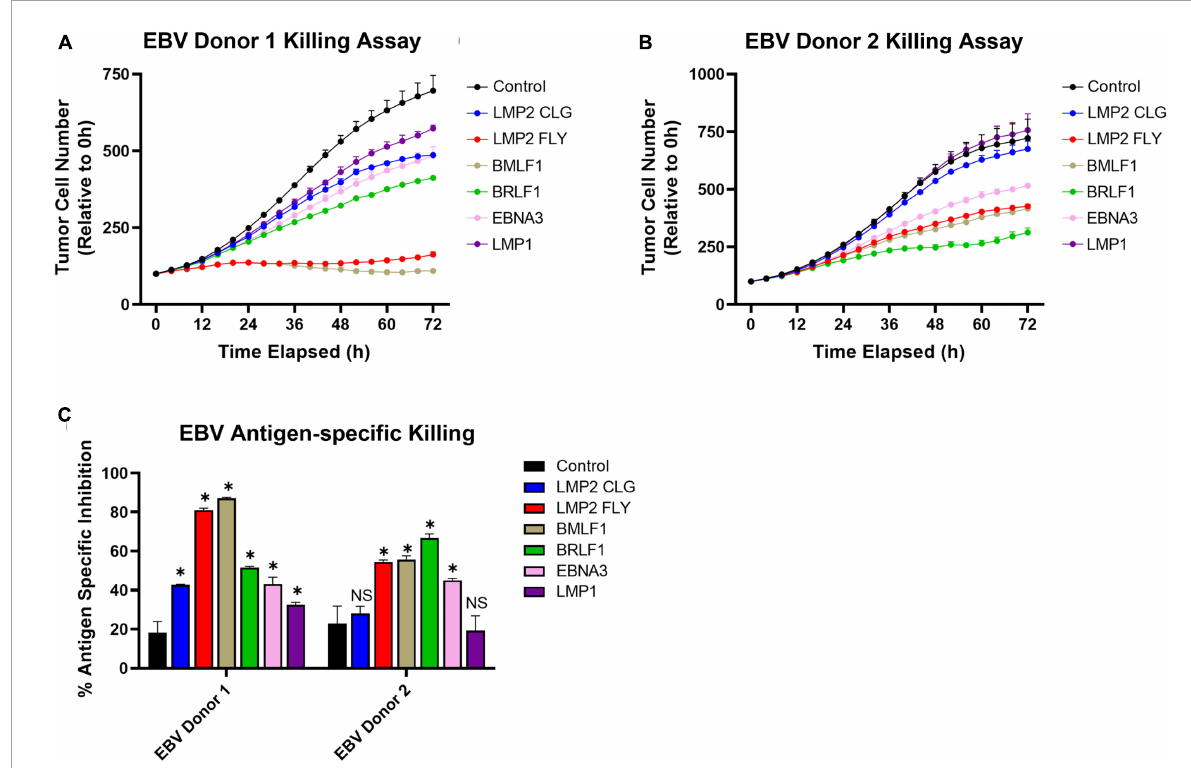
FIGURE5 Multi-antigen specific killing by EBV specific E+E cells from 2 healthy donors. A375 target cells were pulsed with peptides (10 ug/ml); one of six peptides used to enrich and expand T cells, a control HLA-A2-restricted peptide, or no peptide. Then T cells were added to coculture for 72 h at an effector to target ratio of 10:1. Target cells were enumerated by fluorescent microscopy to identify RFP expressing live A375 cells. (A,B) Reported is the relative number of tumor cells compared just after adding E+E cells (0 h). (C) Reported is the percentage reduction in tumor cell number at 72 h compared to when no effector cells were added. Statistical difference was determined by student T test comparing the relative tumor cell number at 72 h for each condition with when the control peptide was pulsed ( p > 0.05 = NS, ∗ p ≤ 0.05). Conditions were run in duplicate wells.